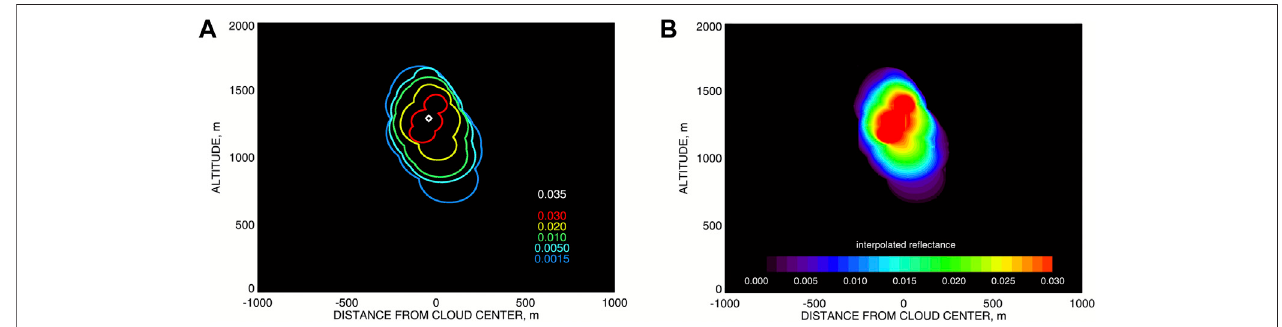
FIGURE6|(A) The nested family ofcloud shapes corresponding to fi ve differentre fl ectance thresholds; themaximal observedre fl ectancevalueisassigned tothe point at the cloud ’ s center (depicted by white diamond). (B) The abstract re fl ectance distribution (RPD) computed by interpolation between the curves in the (A) assuming that each point of each curve is assigned the value equal to the corresponding brightness threshold.